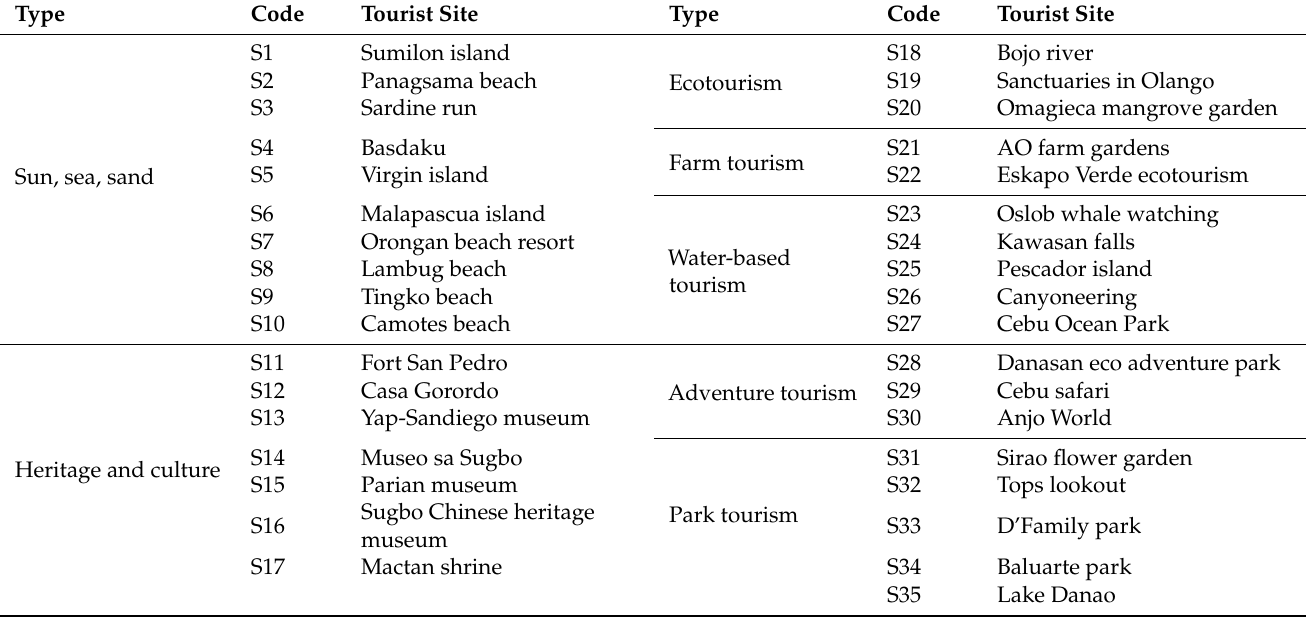
Table 1. List of tourist sites [3].